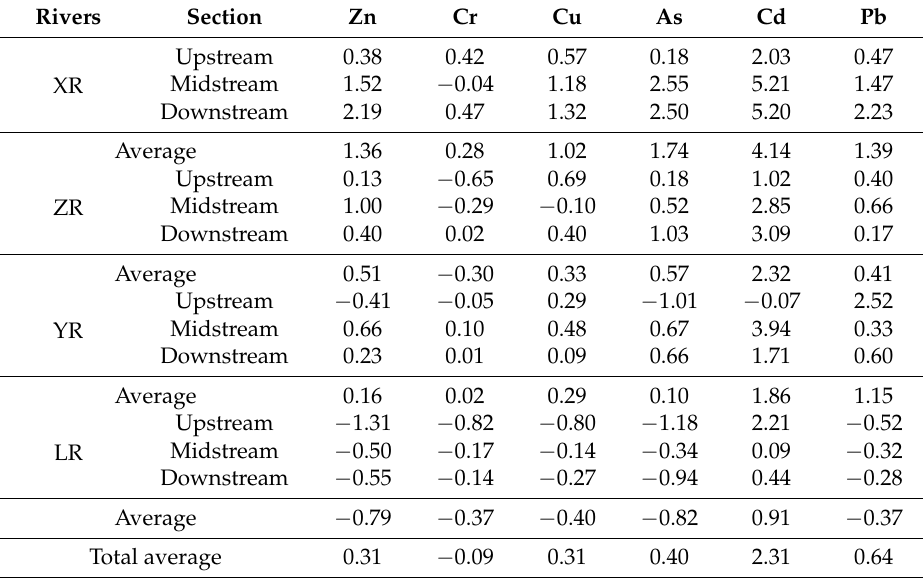
Table 4. I geo of the analyzed metals in the river sediment.